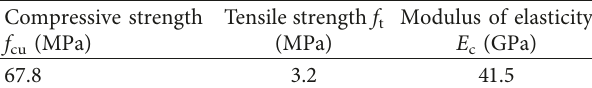
Table 2: Mechanical properties of the concrete component. Compressive